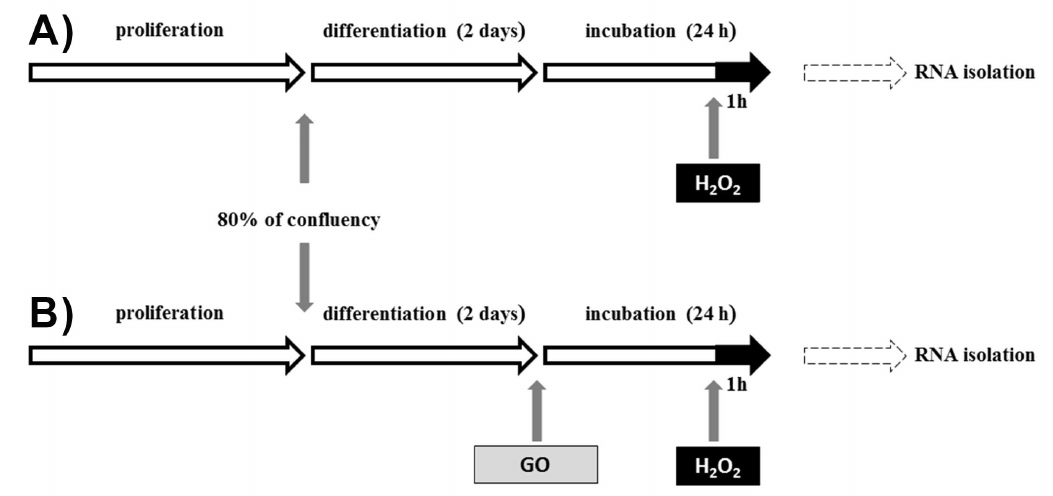
Figure 1. Experimental design: ( A ) control group (ESCs incubated with hydrogen peroxide) and ( B ) GO-treated group incubated with hydrogen